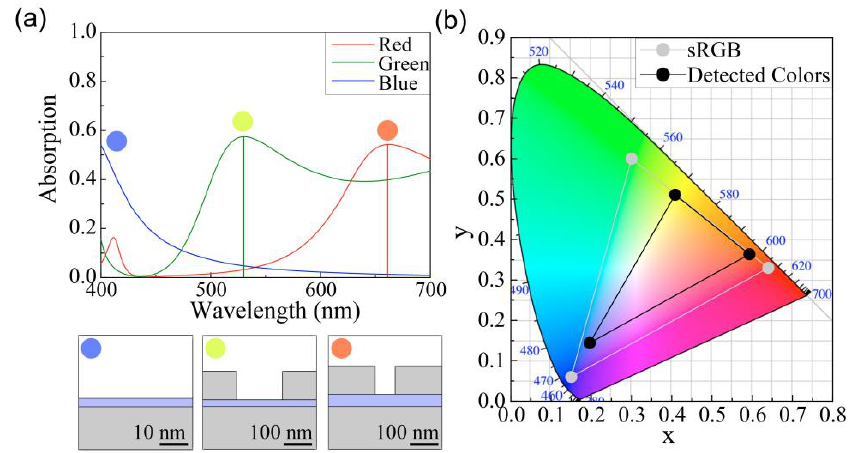
Figure 3. ( a ) Absorption spectrums and ( b ) color coordinates in the CIE color space for three representative detector structures for the colors red, green, and blue. The red and green colors are detected by the structure in which the Ag strips have values of width ( w ) = 357 nm, thickness ( t ) = 56 nm, and w = 239 nm, t = 24 nm, respectively. The blue color is detected by the structure of the InP layer with t = 3 nm on the Ag substrate without the Ag strips. The scaled schematic of each structure is depicted below the graph. The colors detected by each structure are plotted as the colored solid circles, as depicted in the insets of ( a ). The triangular region between the three black dots in the CIE color space in ( b ) represents the possibly detectable colors for the proposed color detectors. This region covers 44% of the sRGB (gray).